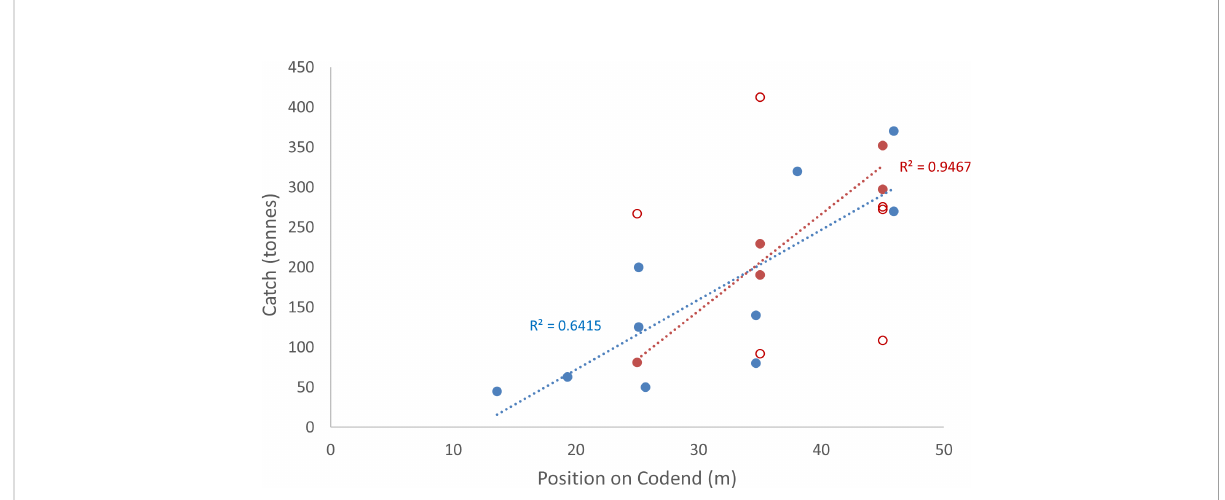
FIGURE 8 The relationship between targeted catch size (tonnes) and the position (in meters) of the catch limitation releaser relative to the forward edge of the codend. Multiple linear regression analysis determined that catch size increased signi fi cantly the further aft the catch limitation releaser was positioned on the codend (t = 5.41; p < 0.001), while there was no signi fi cant difference between the relationships for either cruise (t = -0.40; p = 0.699). Blue dots show results from the fi rst cruise and red dots the second cruise. Open circles show hauls where problems with the releasers were experienced and are not included in the regression